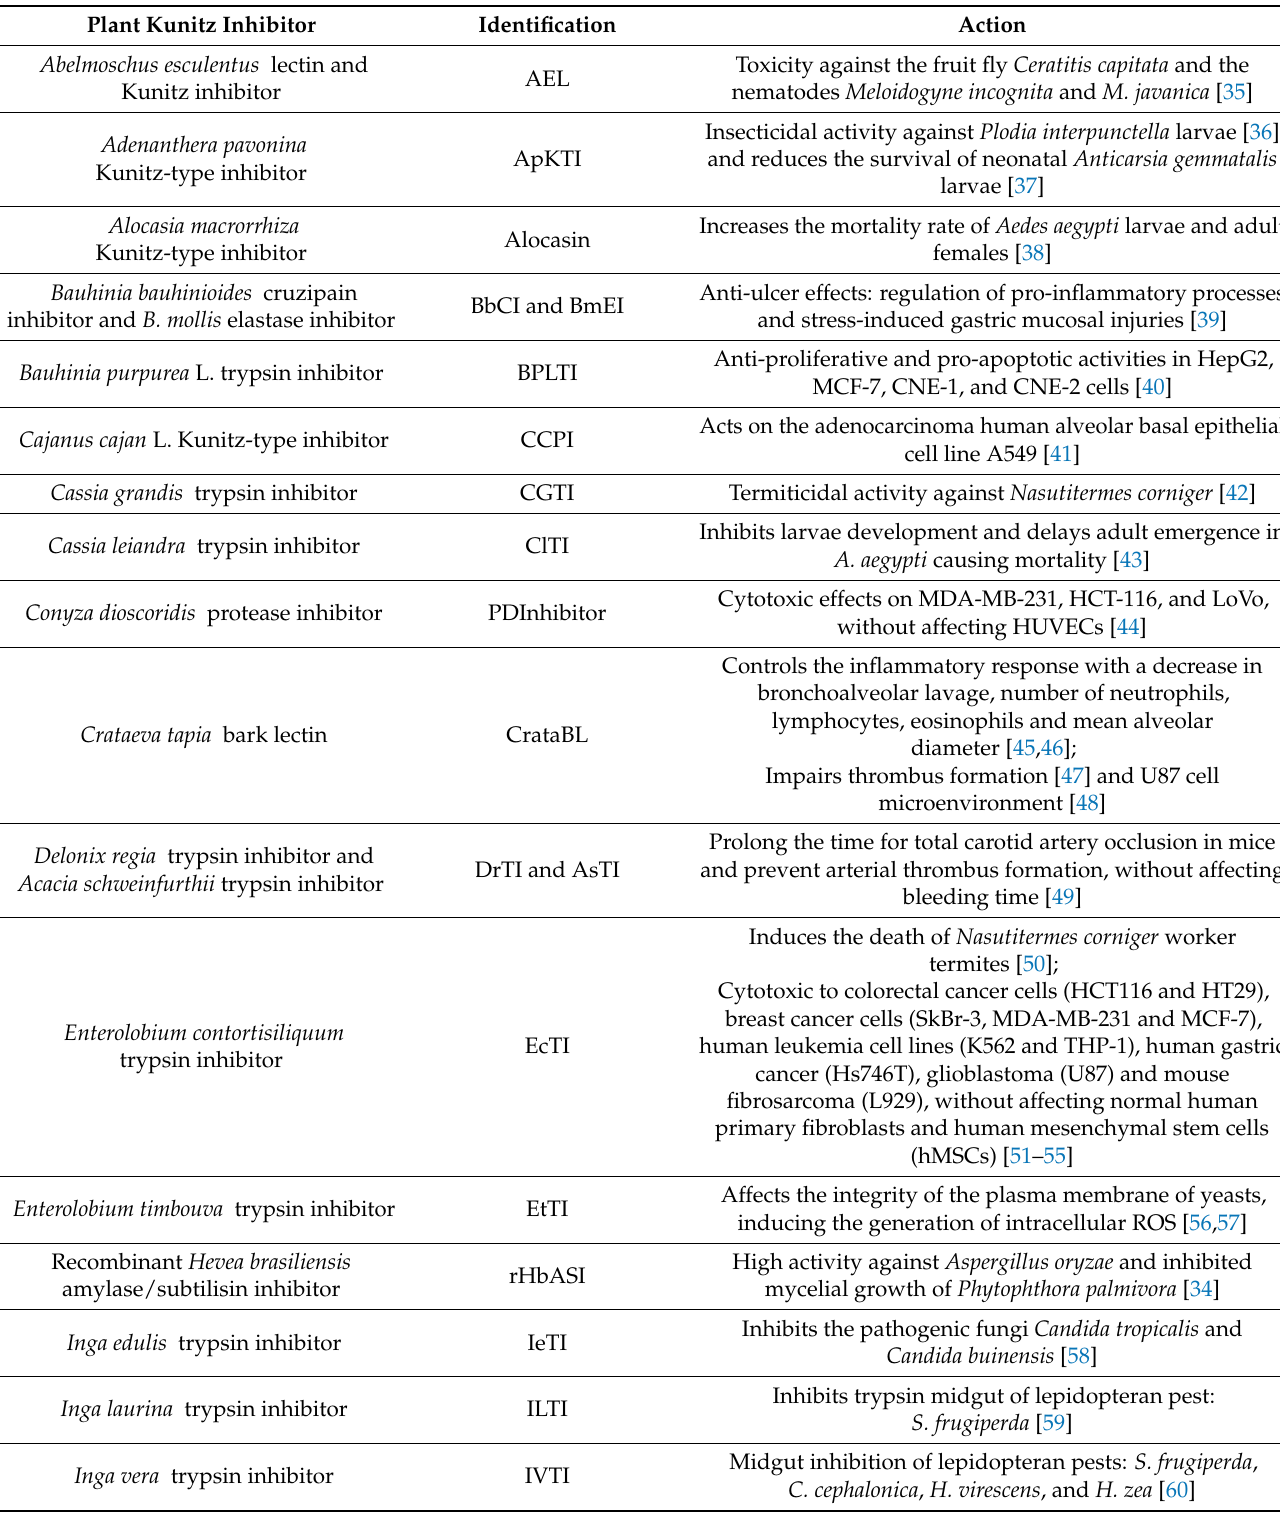
Table 2. Functions of Some Kunitz Protease